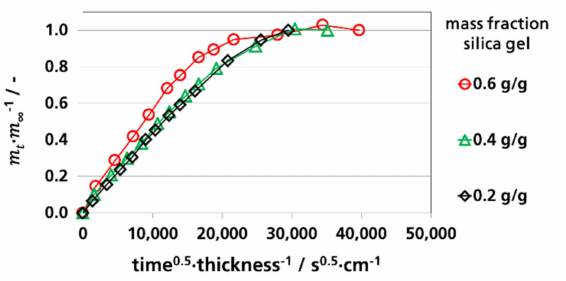
Figure 3. Water vapor absorption of films with dispersed silica gel at 9% RH and 23 ◦ C, determination of D ef f .